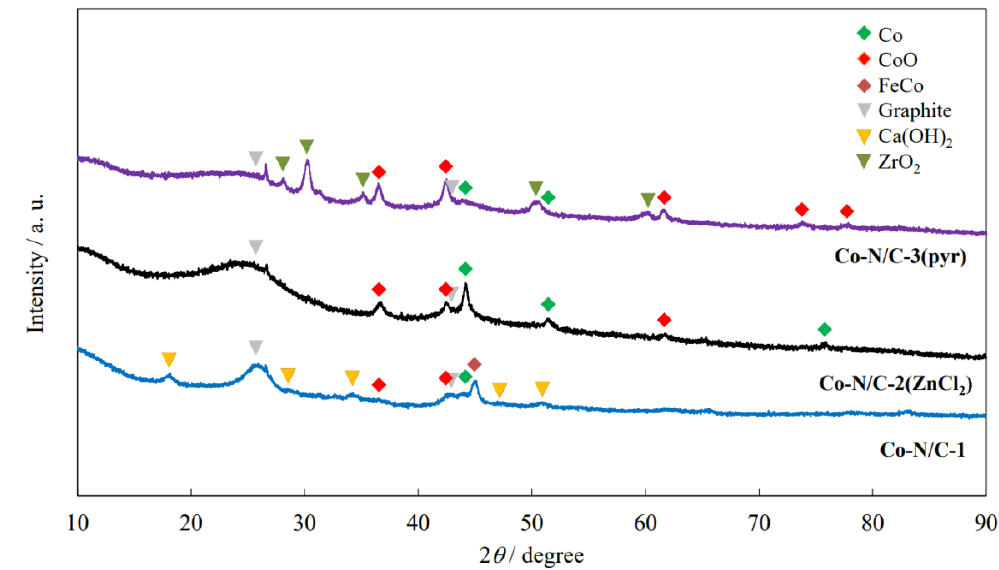
Figure 3. XRD patterns for selected Co-N/PDC catalysts.